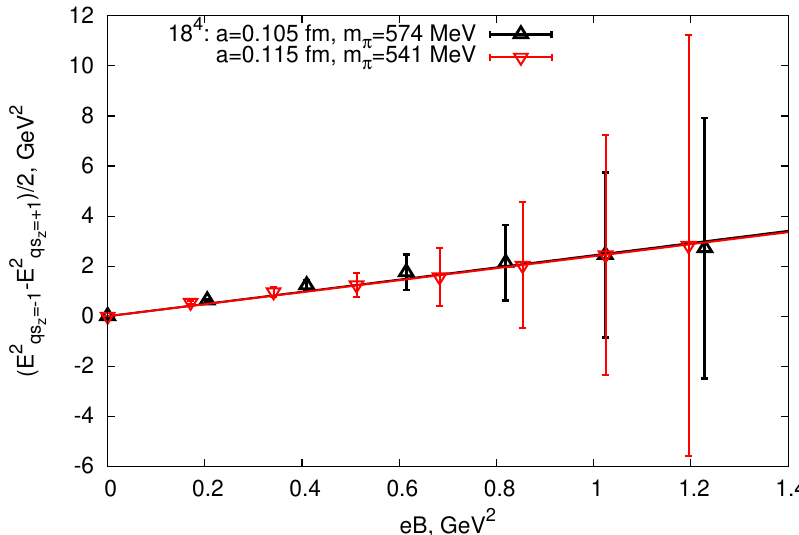
Figure 5 . The value of ( E 2 18 4 , lattice spacings 0 : 105 fm and 0 : 115